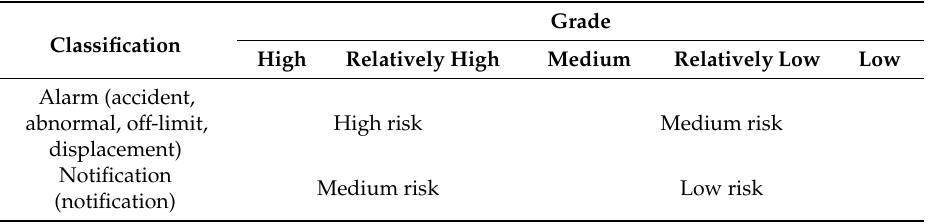
Table 7. Double validation of monitoring alarm